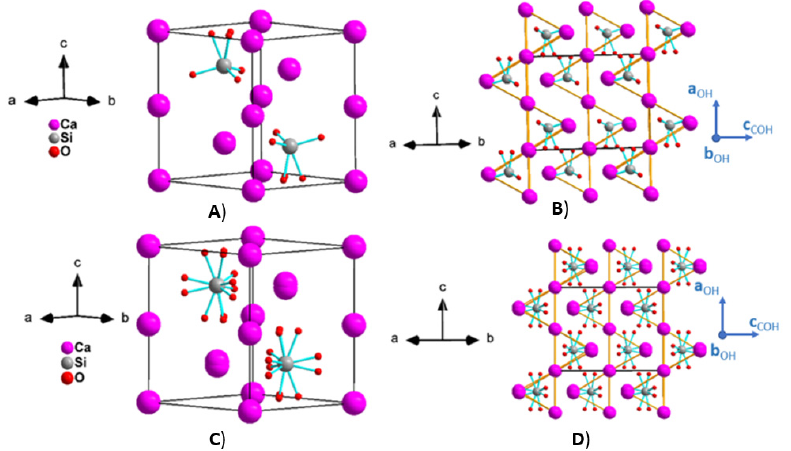
Figure 5. ( A ) The unit cell content and ( B ) the packing arrangement of trigonal prisms for the α Tr -Ca 2 SiO 4 polymorph structural model is shown. ( C ) The unit cell content and ( D ) the packing arrangement of the trigonal prisms for the α H -Ca 2 SiO 4 polymorph structural model are shown. Si-O bonds are indicated with cyan lines. In ( B , D ), the structures are projected on the (11–20) planes, the trigonal prisms are demarcated with orange lines and the relative orientation of the ortho-hexagonal reference system is also indicated.